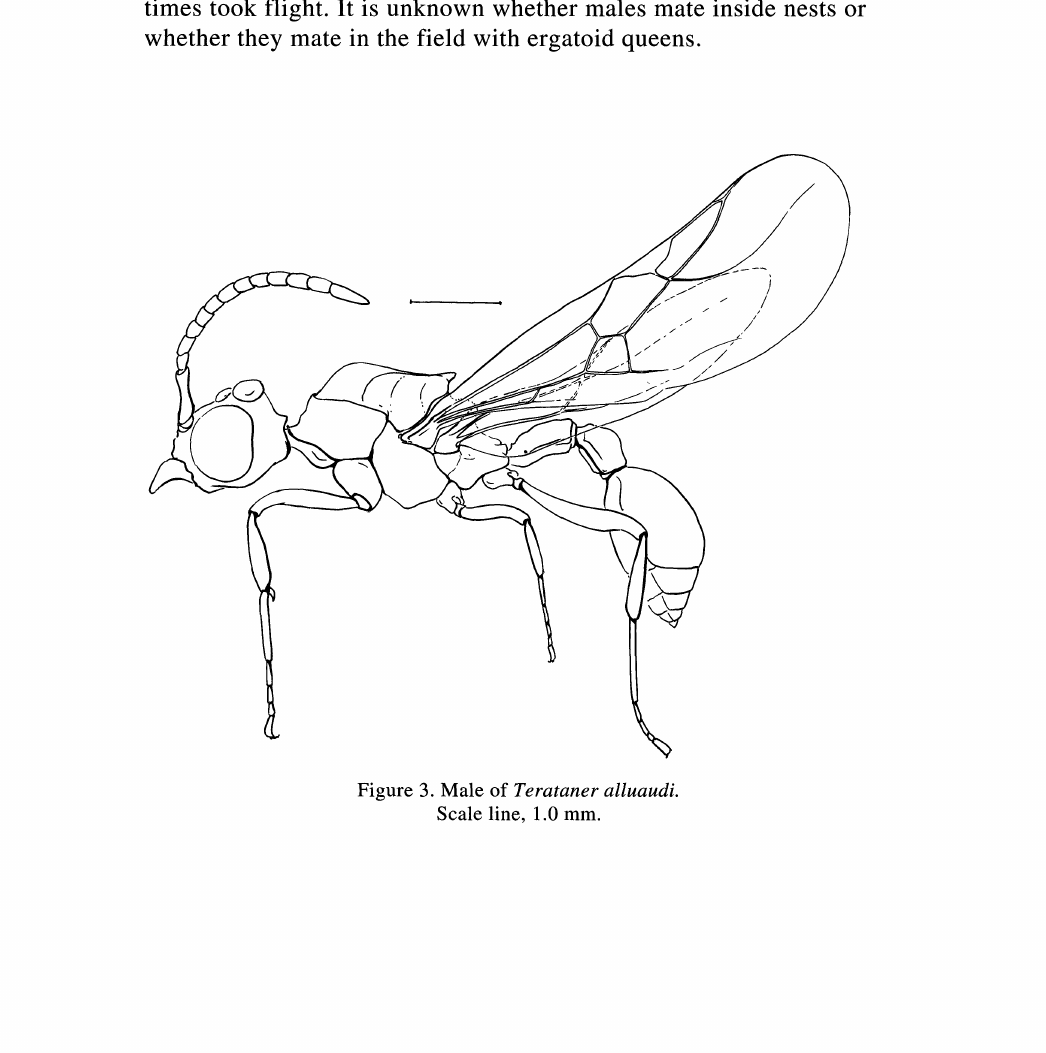
Figure 3. Male of Terataner alluaudi. Scale line, 1.0